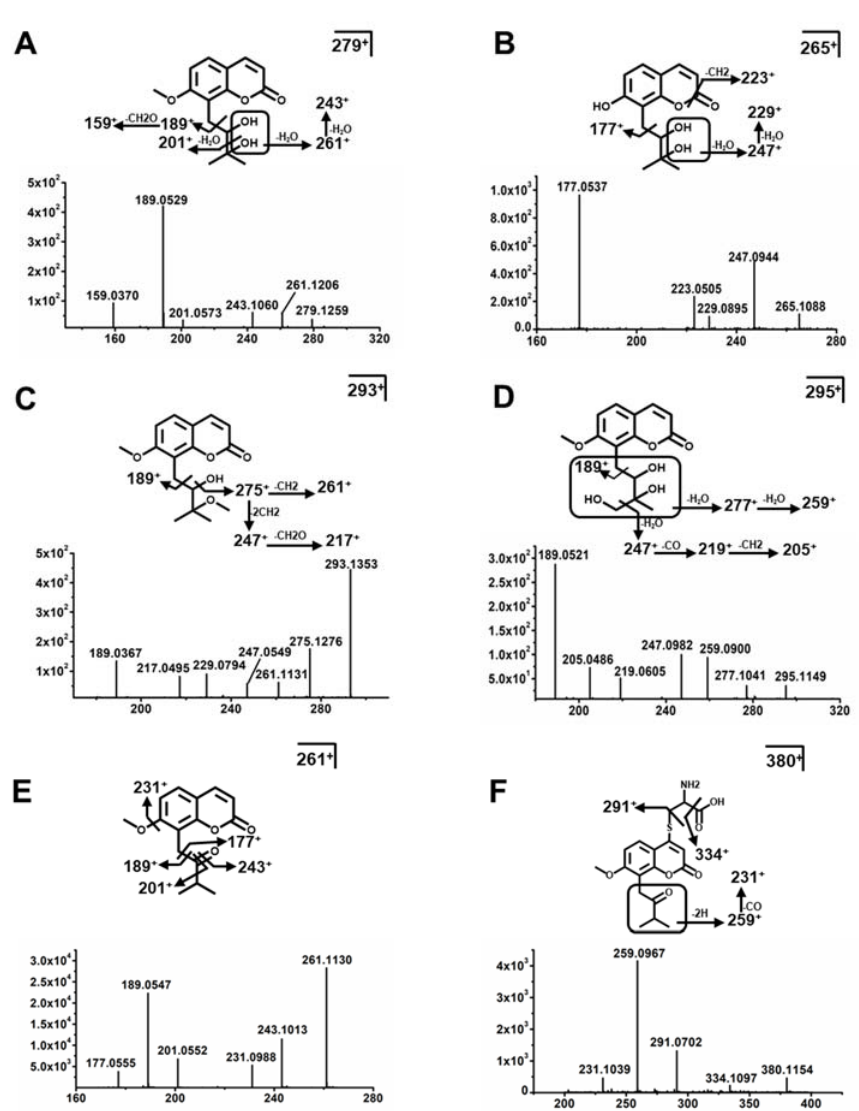
Figure 5. Typical MS/MS fragments of MH and ISM metabolites. MS/MS fragment and structures of Mh0 ( A ), Mh1 ( B ), Mh3 ( C ), and Mh4 ( D ). MS/MS fragment and structures of Mi0 ( E ), Mi9/Mi9a ( F ).